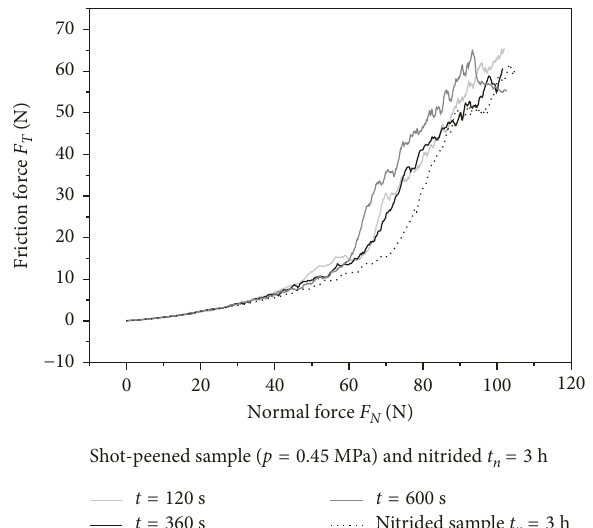
Figure 15: The results of the scratch test of the CrN coating on nitrided substrate and substrates subjected by combined shot peening and nitriding processes, nitriding time t n � 3h.